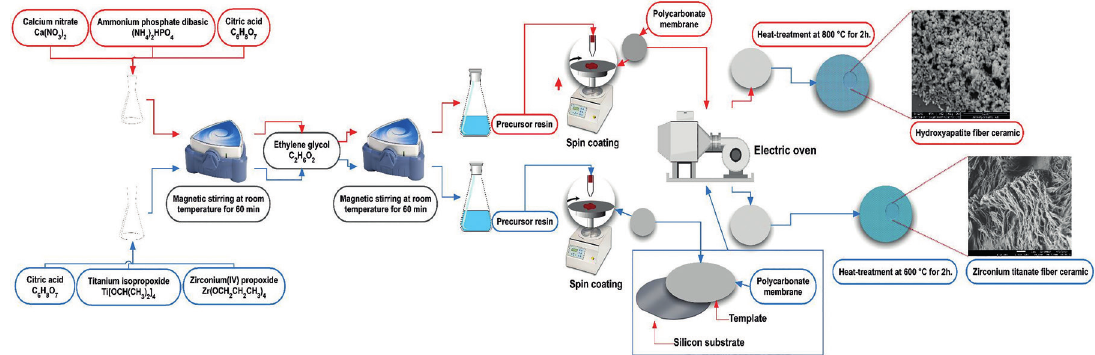
) and Hydroxyapatite fiber 4